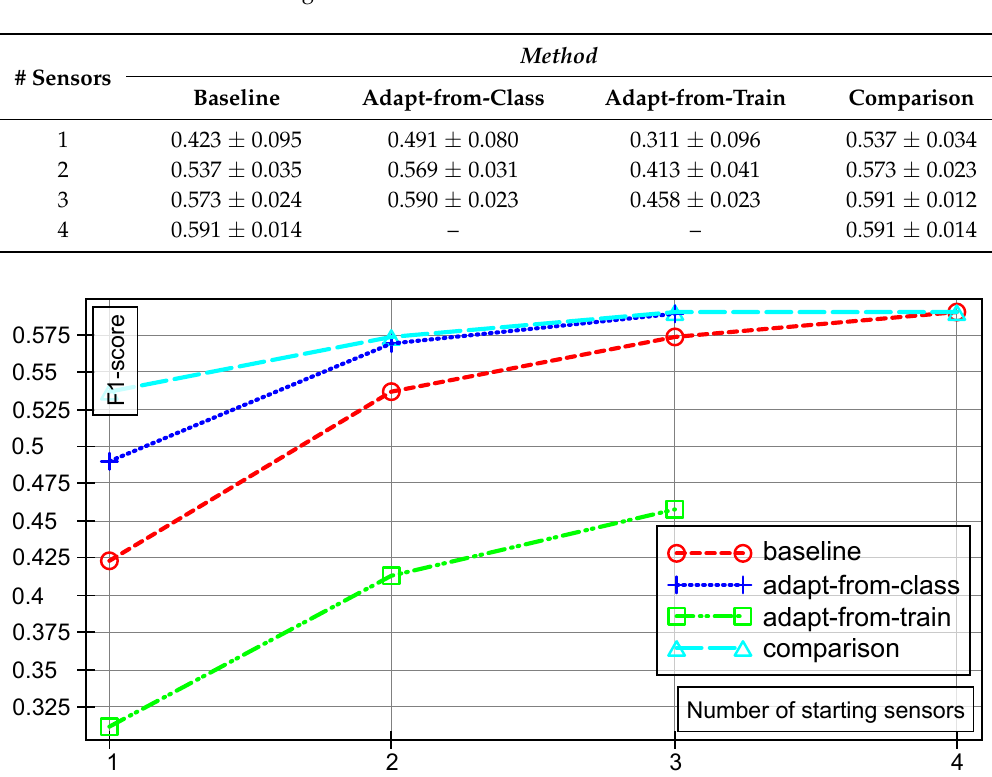
Table 2. Mean F-scores on training data for each number of sensor in the form mean ± standard deviation.